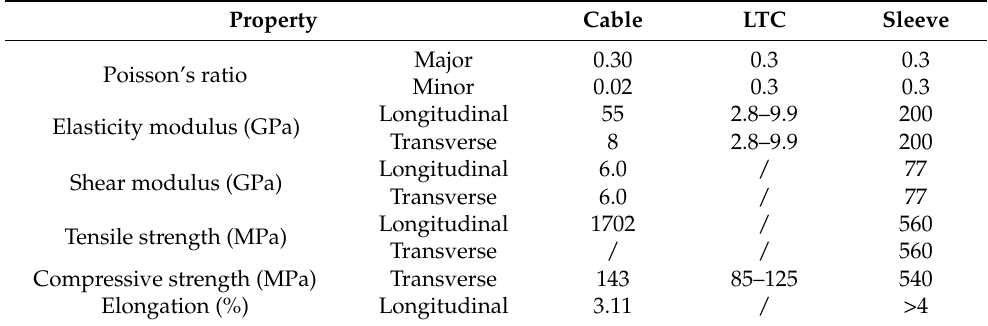
Table 2. Model parameters for the BFRP